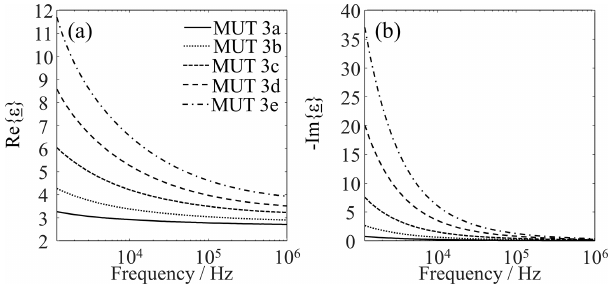
Figure 10. Complex permittivity of MUT 3a–e. (a) Real part. (b) Imaginary part. Each curve is the average of 20 individual mea-